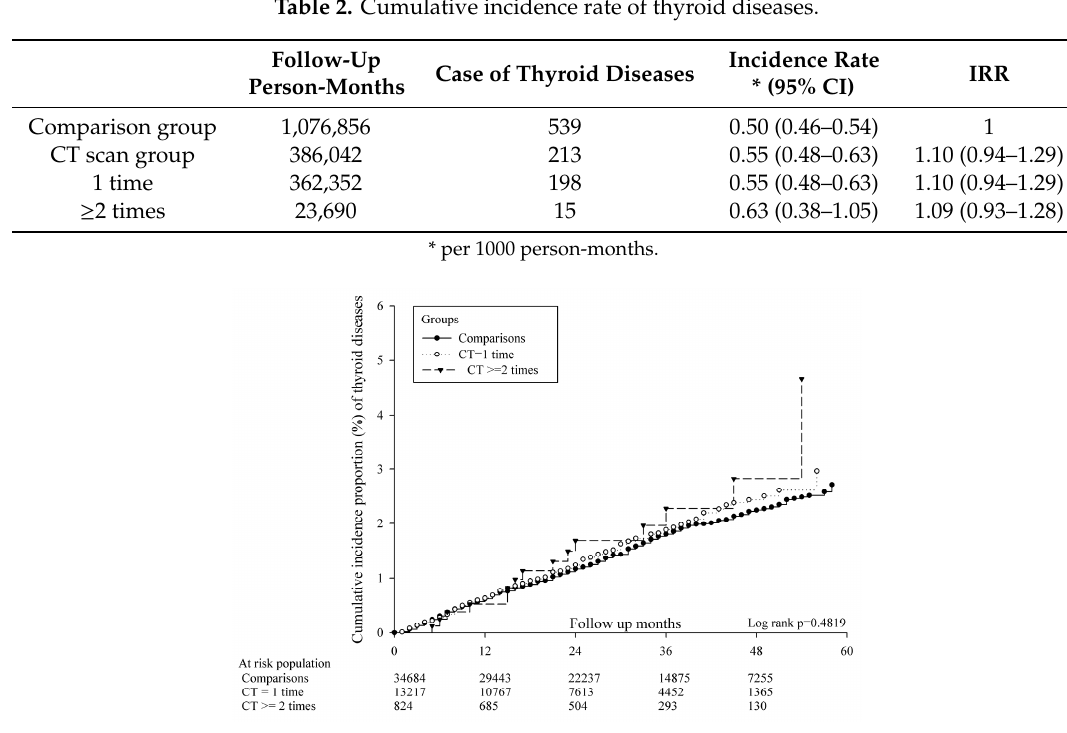
Figure 2. Kaplan–Meier curves of the cumulative proportion of thyroid disease. Table 3. Results of Cox proportional hazards Table 2. Cumulative incidence rate of thyroid diseases.